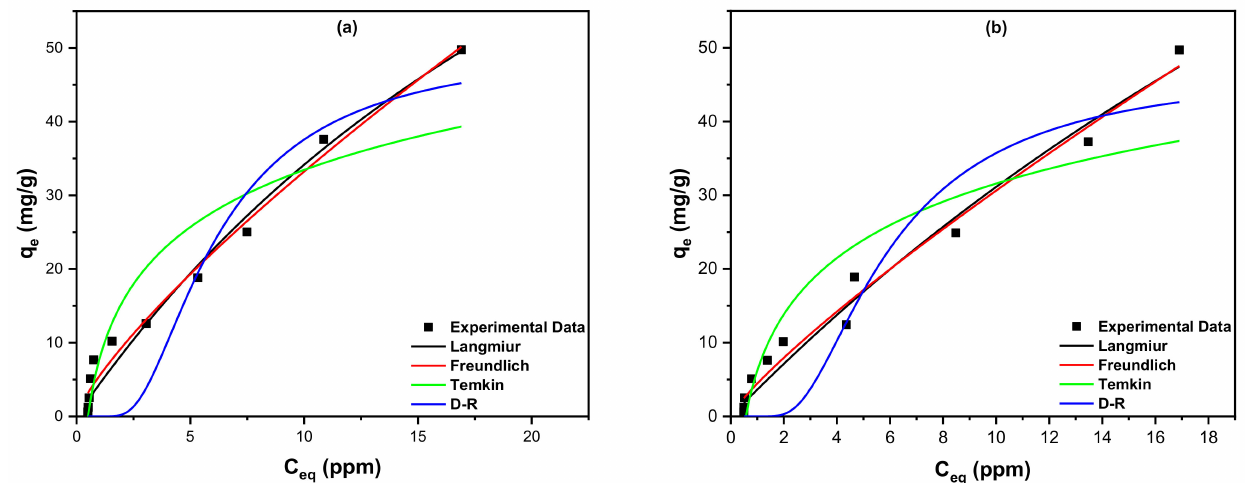
Figure 9. Adsorption isotherms of BALX onto ( a ) SCBC and ( b ) TiO 2 @SCBC including Langmuir, Freundlich, Temkin, and Dubinin-Radushkevich (D-R) isotherms. Table 6. Nonlinear equations of Langmuir, Freundlich, Temkin and D-R isotherms, beside their parameters for the adsorption of BALX on both SCBC and TiO 2 @SCBC.